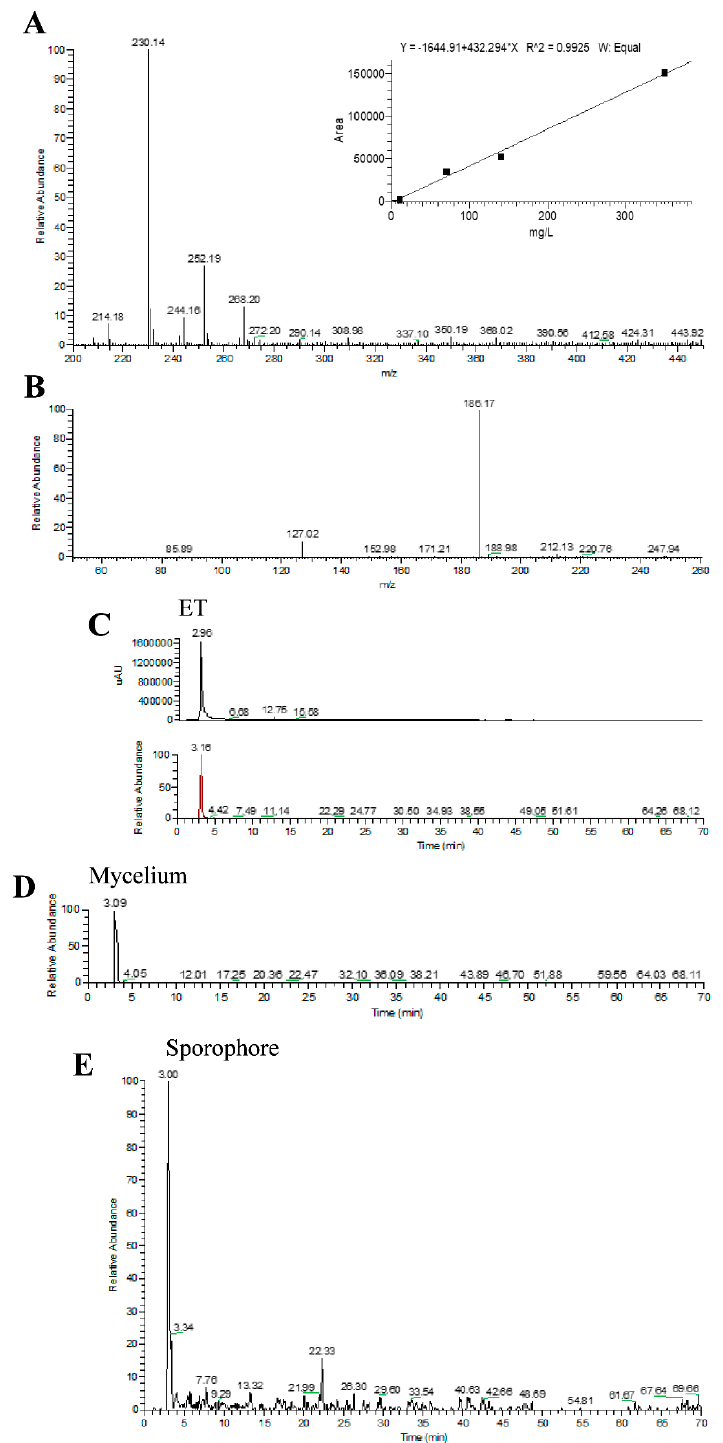
Figure 1. HPLC-UV-ESI/MS was used for quantifying the Ergothioneine (ET) amount in He1 extracts. ( A ) ESI/MS spectrum of ET. Panel (top, right) reports calibration curve and linear regression curve for ET. ( B ) ESI-MS/MS spectrum of ET obtained by fragmentation of ion m / z 230 shows two fragment ions m / z 186 and m / z 127. ( C ) Standard molecule of L-(+)-ET at 70 ppm: UV trace (top) and mass spectrum (MS)/MS Selected Reaction Monitoring m / z 230 > m / z 186 trace (bottom). ( D ) MS/MS Selected Reaction Monitoring m / z 230 > m / z 186 trace of He1 mycelium. ( E ) MS/MS Selected Reaction Monitoring m / z 230 > m / z 186 trace of He1 WT